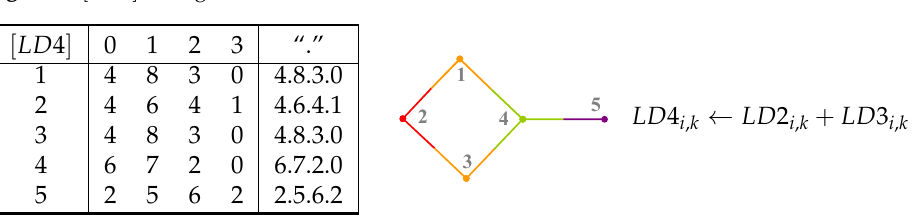
Figure 9. [ LD 3 ] on Figure 1.